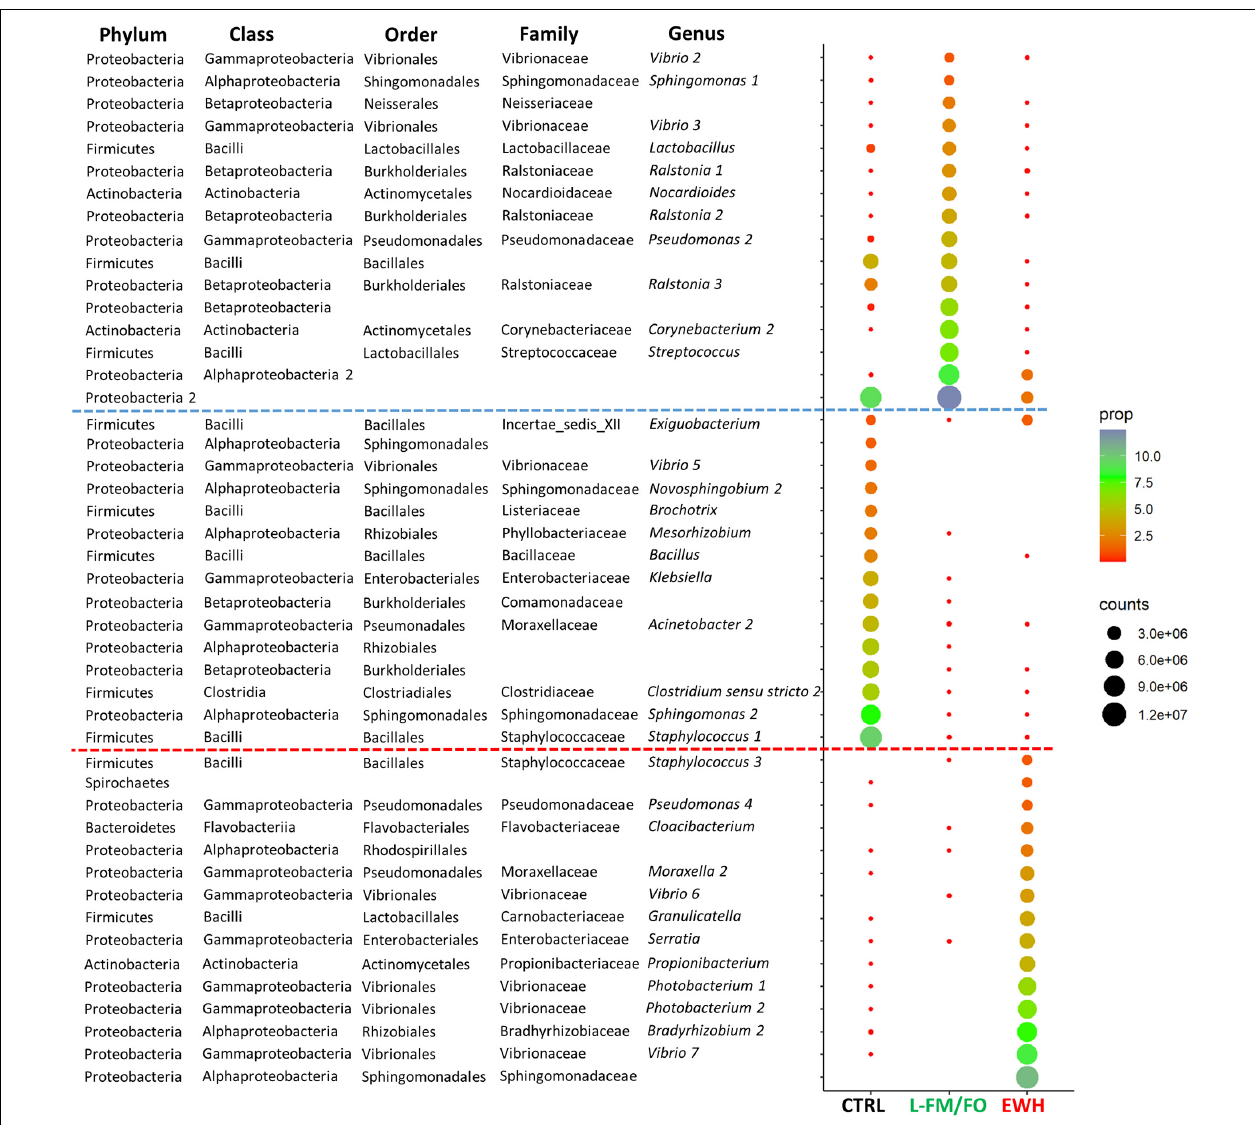
FIGURE 6 | Dotplot map depicting the most abundant genera (more than 1% of the total microbiota in at least one dietary group) from the 165 significant OTUs identified in Figure 5B . The size of the dots represents the normalized counts in each dietary group (CTRL, L-FM/FO, and EWH). The color scale represents the mean abundance, in percentage, of each genus within each group. OTUs above the blue dotted line showed an increased abundance in L-FM/FO groups; OTUs between the dotted lines showed an increased abundance in the CTRL group; OTUs below the red dotted line showed an increased abundance in the EWH group. The numbers after the genus names correspond to different OTUs assigned to the same genus that probably belong to different